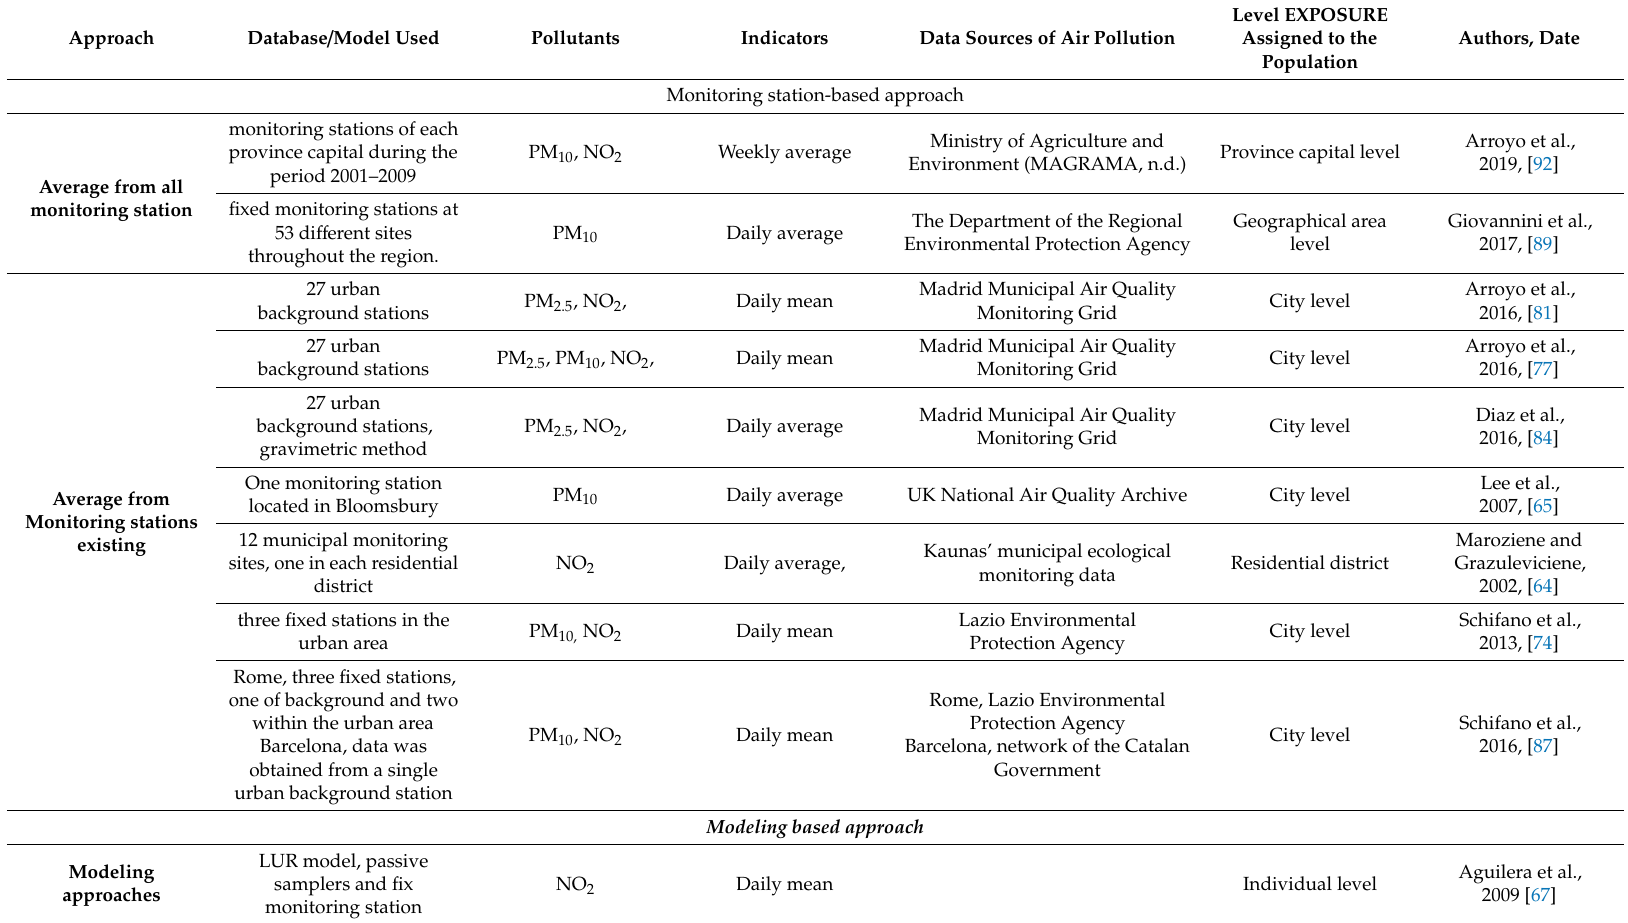
Table 3. Summary of approaches used to assess the residential exposure